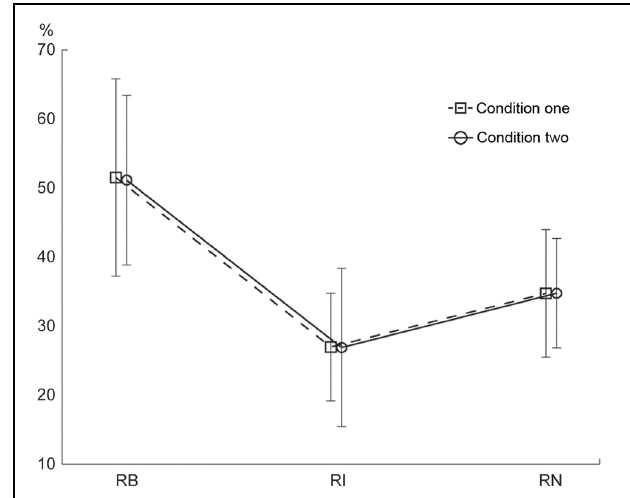
FIGURE 6 | Percentage of correctly reproduced rhythms. The percentage of correctly reproduced rhythms was higher for the 1:2:4:8 rhythm type than for the 1:3:5:6 and 1:2.3:5.3:6.4 rhythm types. Error bars indicate ± 95% confidence intervals (Loftus and Masson, 1994; Masson and Loftus, 2003). RB, RI, and RN represent rhythms formed with binary, non-binary integer, and non-integer ratios,